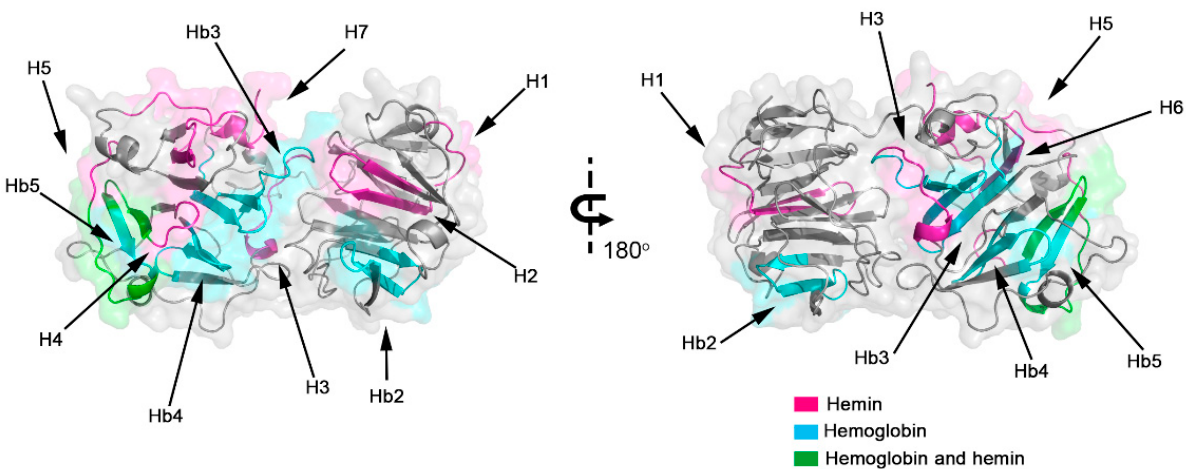
Figure 2. Model of human hemopexin with interaction domains with hemin and hemoglobin. The 3D protein conformation and structure were determined using a homology model, and the interaction regions are highlighted for Hx interaction sites with hemin (magenta), hemoglobin (cyan), and both molecules (green), indicating the positions of the 12 linear sequences identified by spot-synthesis (Table 1).